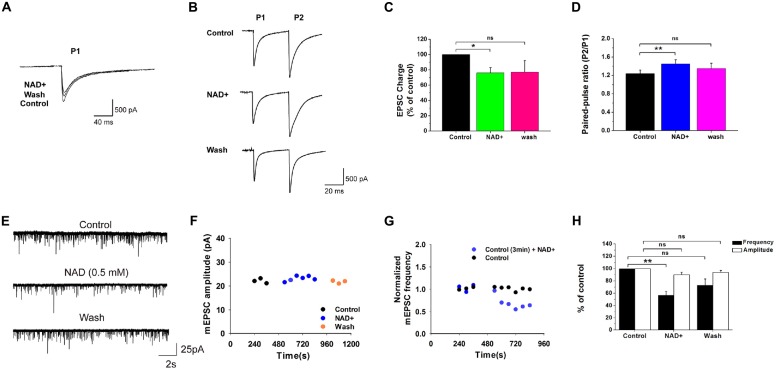
Effects of nicotinamide adenine dinucleotide (NAD+) on miniature excitatory postsynaptic currents (mEPSCs) and evoked EPSCs. (A) Evoked EPSCs recorded from a neuron in the presence of strychnine and bicuculline. NAD+ decreased the response charge in this cell. (B) EPSCs was evoked in a neuron during paired-pulse stimuli with an interval of 20 ms. NAD+ decreased the first EPSC (P1) but increased the paired-pulse ratio (PPR; P2:P1) in this cell. Stimulation artifacts were manually removed to improve the clarity in (A,B). (C) Mean value of normalized charge of the first EPSC in control, during NAD+ and washout solutions. (D) Mean value of PPR of EPSC charge in control, during NAD+ and wash solutions. (E) Typical mEPSCs recorded from a neuron during control, 0.5 mM NAD+, and washout. (F) Time course of average amplitude of mEPSCs along sample experiments of Panel (E). (G) Representative time course of the effect of NAD+ on normalized frequency of mEPSCs in a neuron. The control solution was applied for 6 min, followed by the bath application of 0.5 mM NAD+ for 8 min. The frequencies of mEPSCs were measured for last 3 min in control and last 6 min in NAD+ (blue circles). By comparison, in a control experiment the same measurement was made with only vehicle application (black circles). (H) Histograms depicting the effect of NAD+ on mEPSCs frequency and amplitude. Error bars represent standard error; *P < 0.05; **P < 0.01; ns: not significant, one-way analysis of variance (ANOVA) with Student-Newman-Keuls post hoc test.